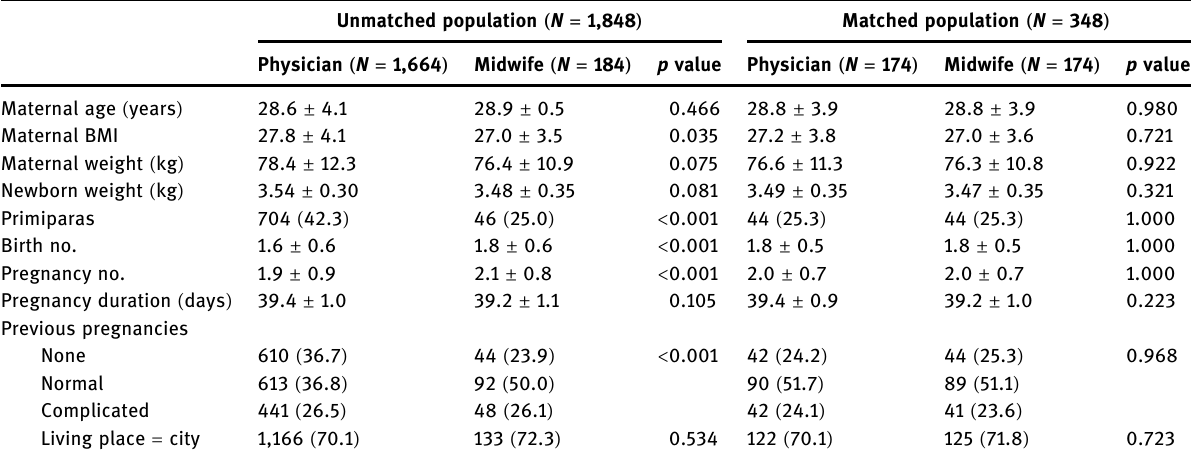
Table 1: Sociodemographic characteristics of study participants in the unmatched and matched study populations